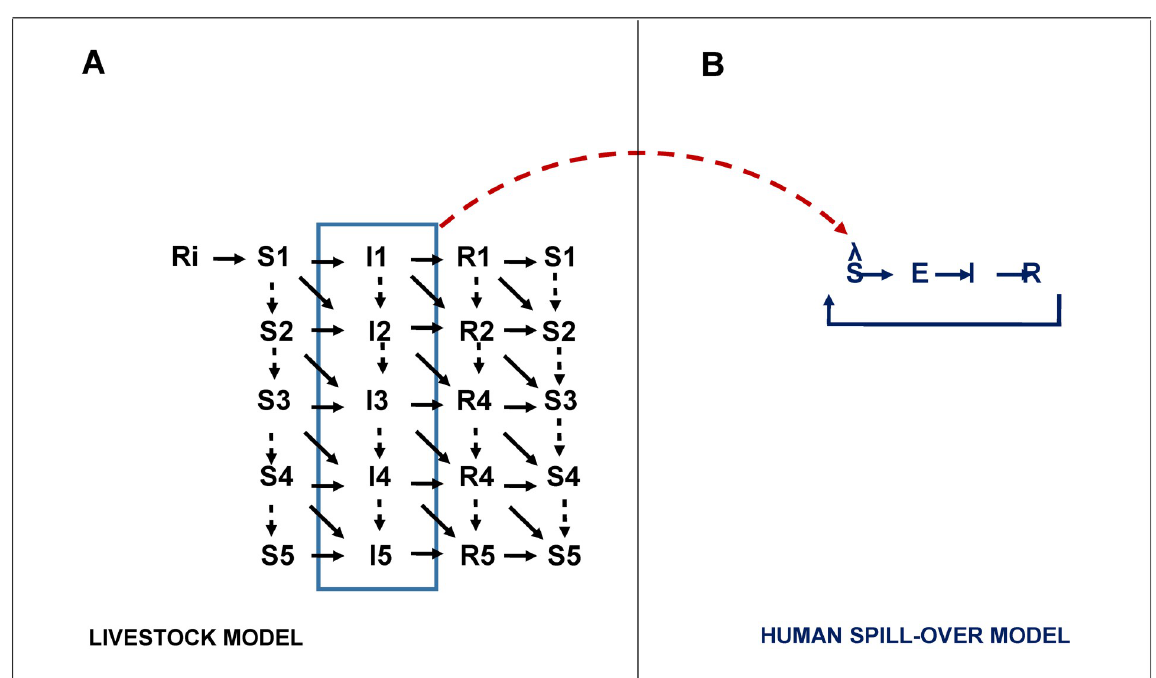
Fig 1. Model schematic of CCHFV transmission. We modelled CCHFV viral transmission between livestock, and from livestock to humans. In panel A, livestock were stratified in five yearly age-groups. Animals are born into the model at a rate proportional to mortality to maintain equilibrium. A fraction of livestock will acquire immunity through colostrum exposure in the first days after birth, here denoted as compartment Ri, the remaining fraction will enter the model through S1. The fraction moving to Ri is proportional to CCHFV prevalence at each time t. We assume a colostrum acquired immunity loss after six months. We model transmission between livestock with a risk function that renders the expected tick activity as a function of environmental drivers, and incorporates CCHFV infection prevalence in livestock and a scaling factor for the climatic indicator.. Infectious animals (I) recover after seven days, on average passing into the recovery compartment (R). We assume waning immunity with an average rate of 5 years -1 , hence the transition R - > S. (B), we formulate the human spillover structure as an SEIRS model, governed by a series of stochastic transition events. Transmission follows a force of infection λ , that is defined by the infectious P 5 I a livestock prevalence at time t and a relative risk of transmission that conveys the differential risk by human occupation (i.e., farmers, f a ¼ 1 g N L and other). This connecting link is represented by the red dashed arrow connecting the two models. This implies a sequence of events in the runtime in which a realisation of the animal model is run over the time period, producing a vector of prevalence as output. This vector is subsequently passed as an input to the human spillover model. From the structure in panel B, is also evident that we allow a loss of acquired immunity R- > S.